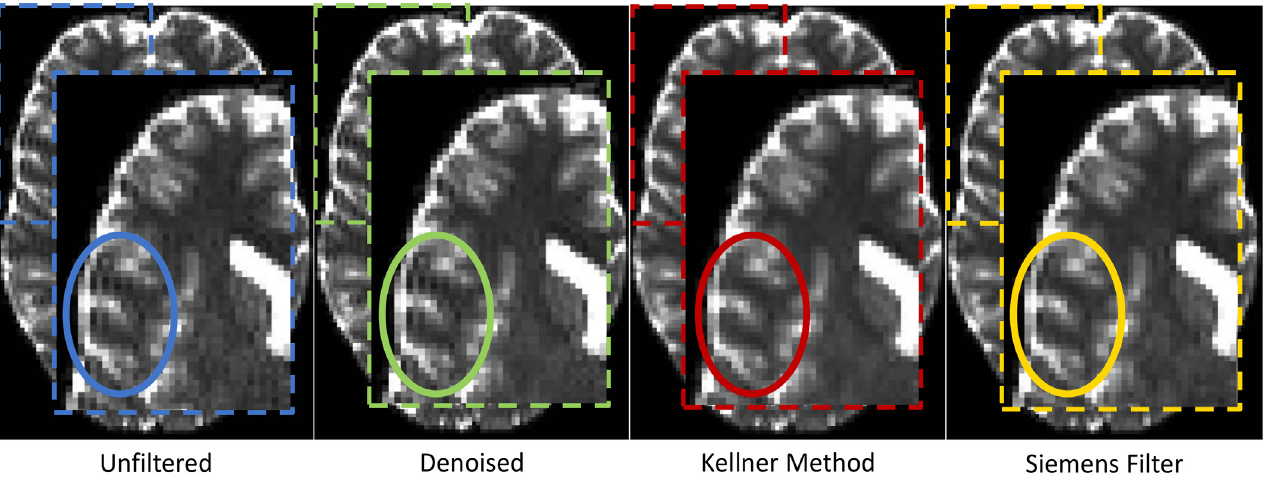
Figure 8. Appearance of Gibbs ringing artefact in b0 (T2-weighted) images after applying different preprocessing tools. Note that only the unringing tool (red) from Kellner et al. [48] considerably reduced GR as is most evident in the circled part of the b0 image.